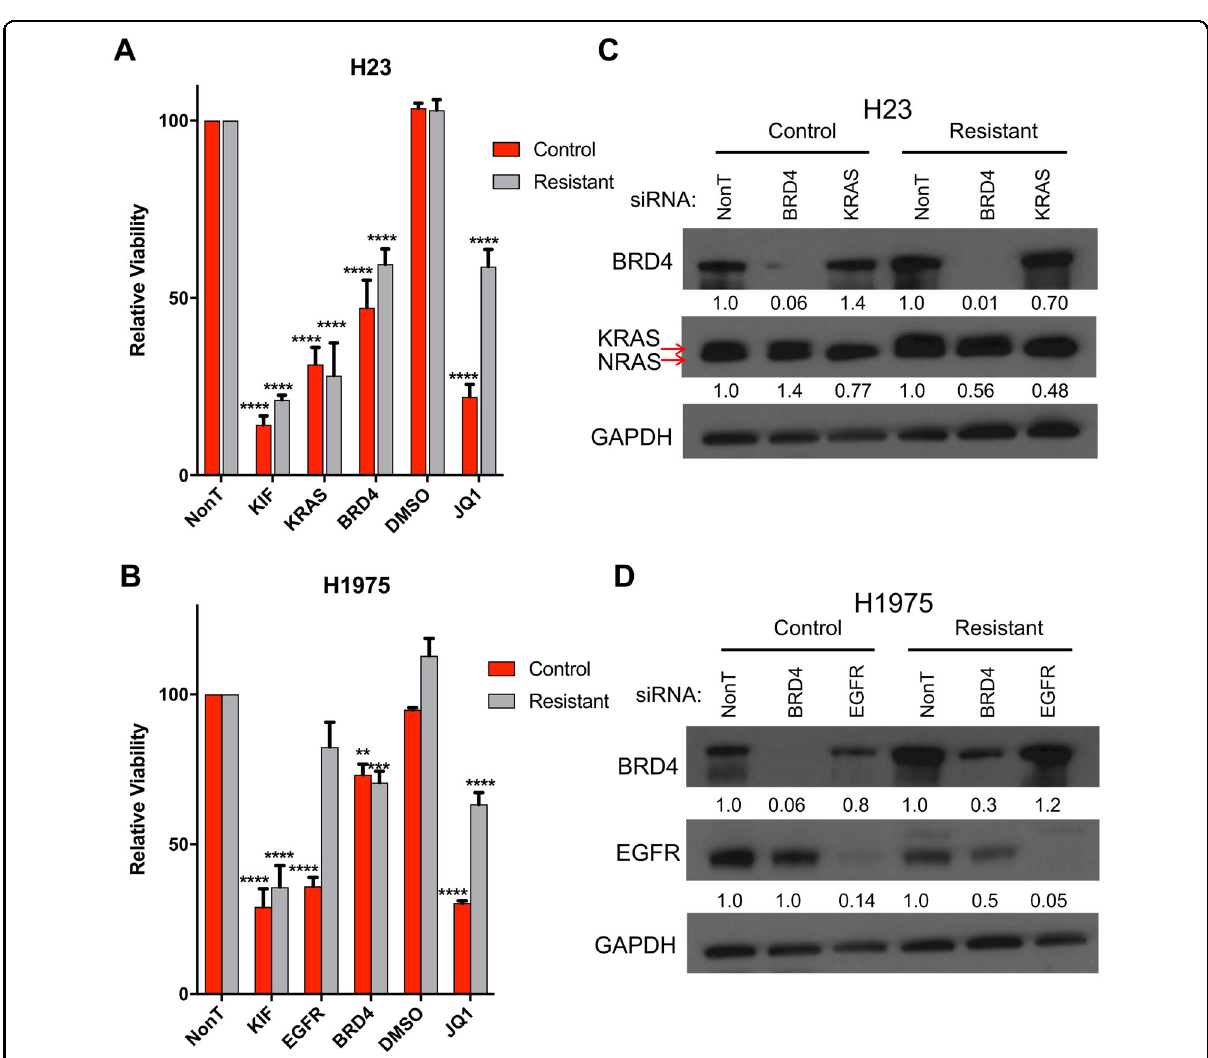
Fig. 4 JQ1 resistant LAC cell lines are still dependent on BRD4 for survival. Relative viability following siRNA knockdown in H23 ( A ) and H1975 ( B ) JQ1 resistant and control lines. Cell lines were transfected with the indicated siRNAs and viability was assessed 96 h after transfection using Alamar Blue. Values are relative to the Non-target (NonT) siRNA control and represent the mean of triplicate experiments (error bars indicate SEM). KIF and KRAS/EGFR act as positive controls in the indicated cell lines. Asterisks denote level of statistical signi fi cance between the control and resistant line (* P < 0.05; ** P < 0.01; *** P < 0.005; **** P < 0.001) using two-way ANOVA. C , D Western blot lysates were collected 72 h after transfection and analyzed, with GAPDH serving as a loading control. Relative change in protein levels (calculated by densitometry as in Fig. 2) for each cell line condition compared to NonT control are indicated below each